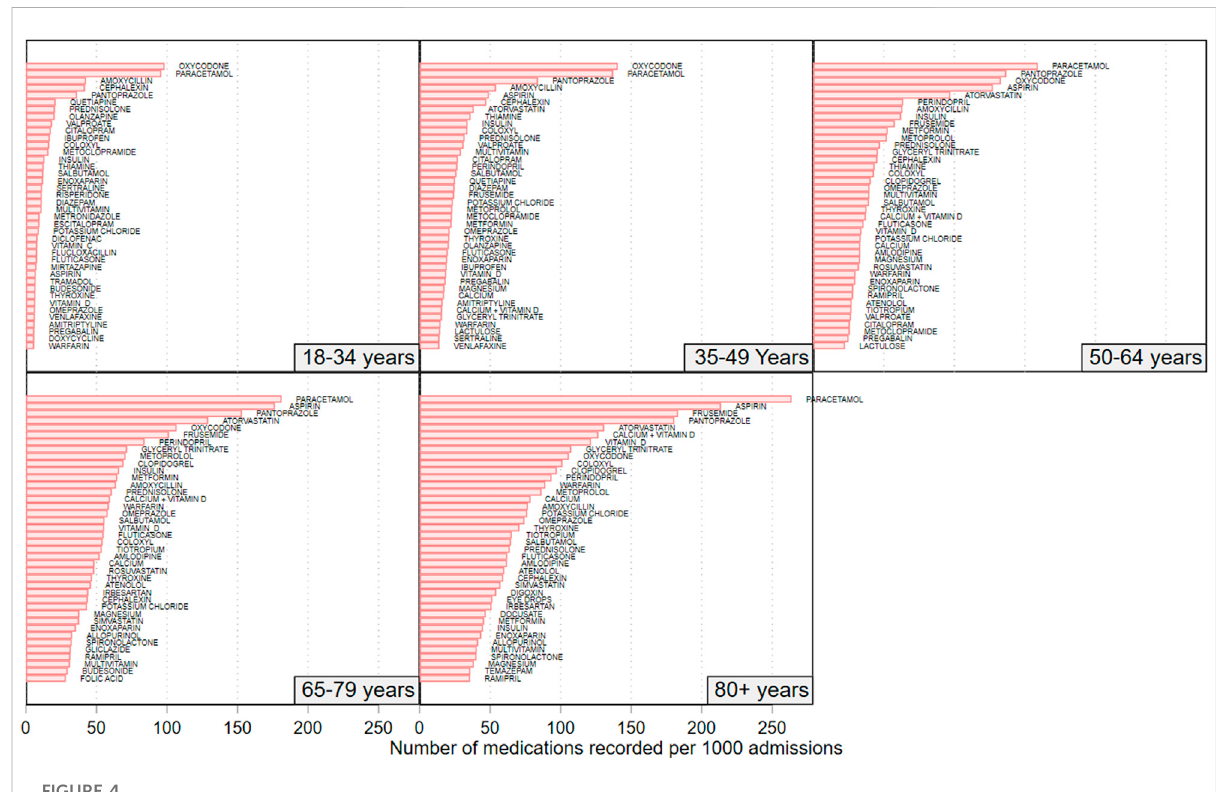
FIGURE 4 Rate of recorded medications for the top 40 recorded medications amongst patients in each of the studies 5 age groups. N = 692,522